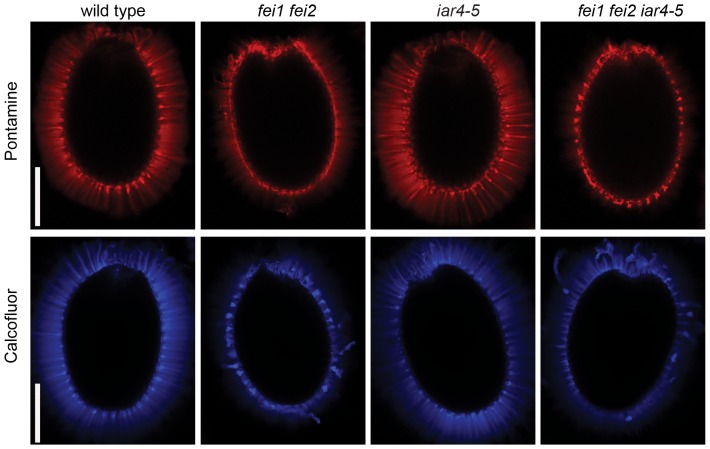

iar4 does not suppress defects in the seed coat mucilage of fei1 fei2.Seeds of the indicated genotype were stained as described in the Methods with either Pontamine fast scarlet S4B or calcofluor as indicated and visualized by confocal microscopy. Scale bar = 0.2 mm.